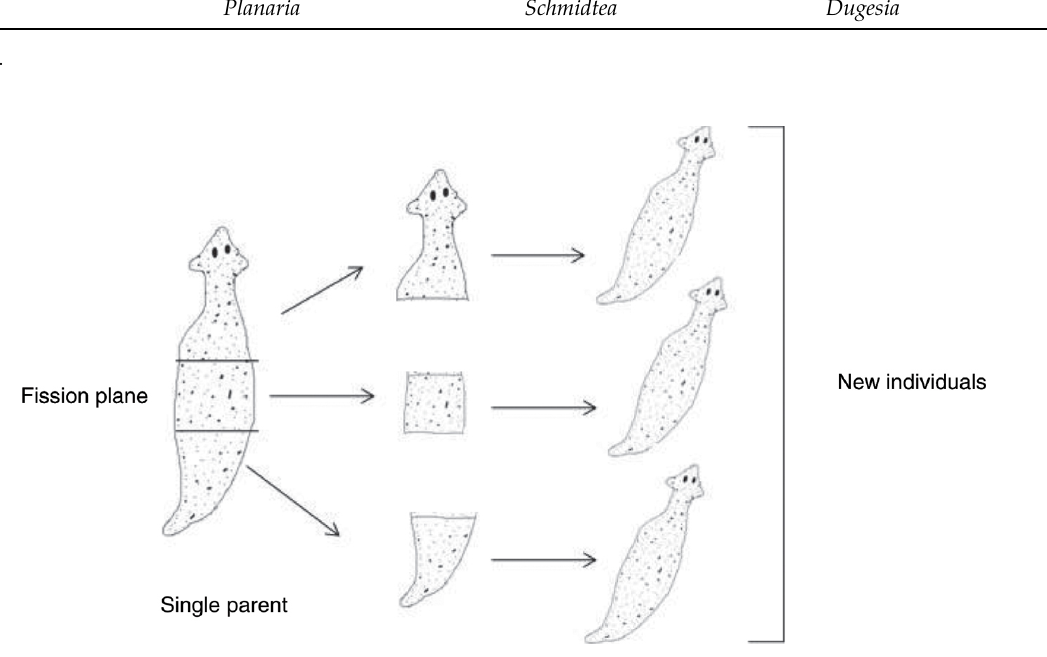
Figure 1: Architomy in Planaria: a mode of asexual reproduction by which a single individual regenerates into new indi- viduals.